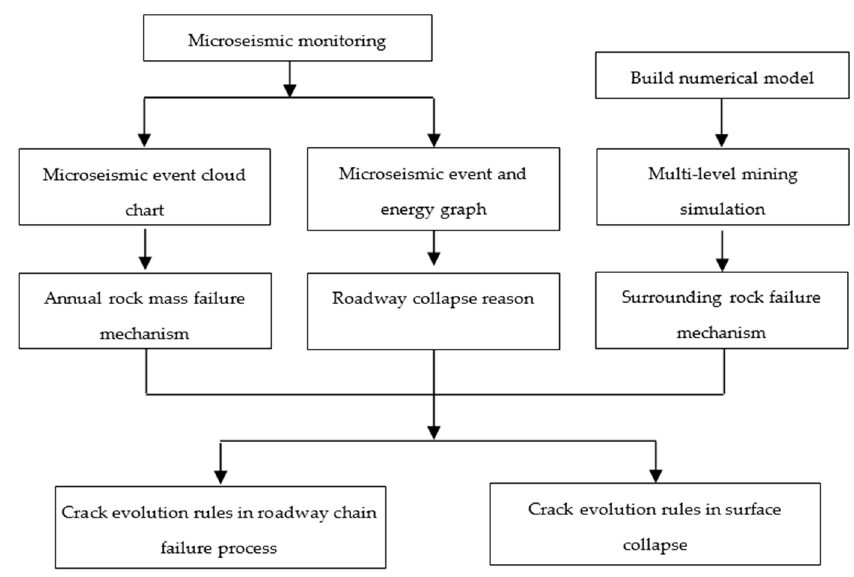
Figure 5. The research framework map.